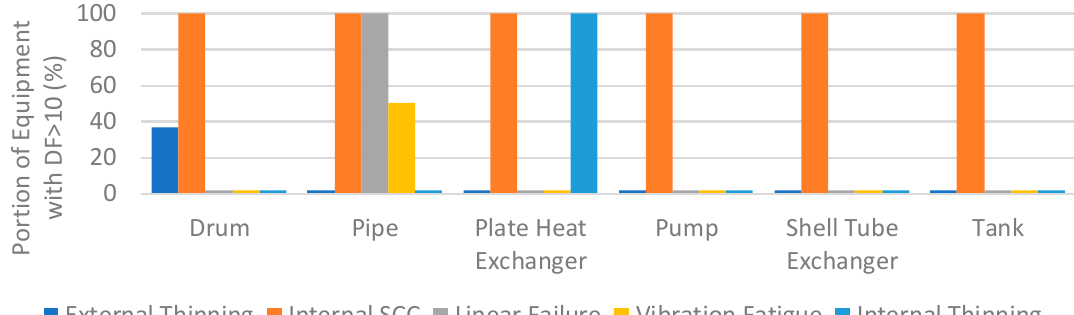
Figure 5. Active Damage mechanisms per equipment of the Oil Production Unit. DF stands for Damage Factor, and SCC stands for Stress Corrosion Cracking.